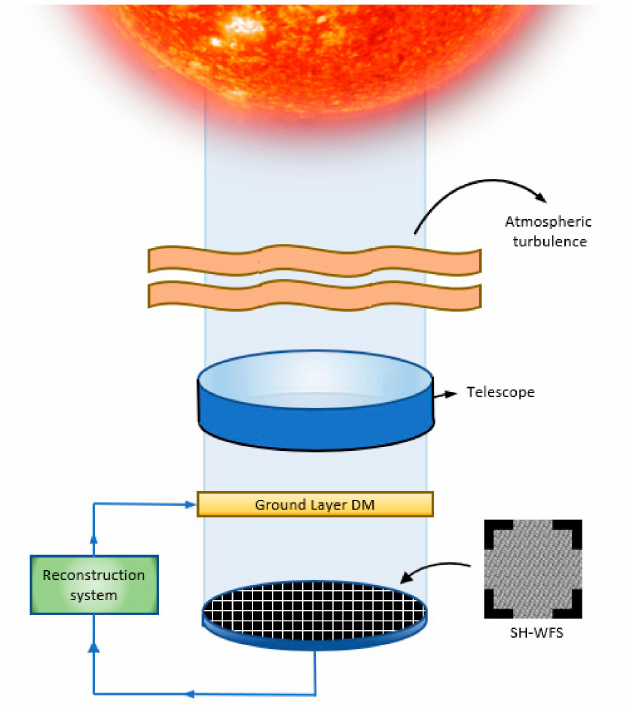
Figure 2. Solar Single Conjugate Adaptive Optics (SCAO)